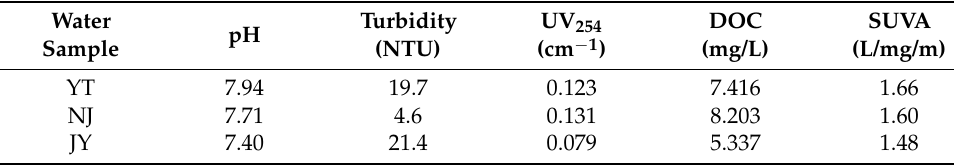
Table 3. Basic water quality parameters of experiment